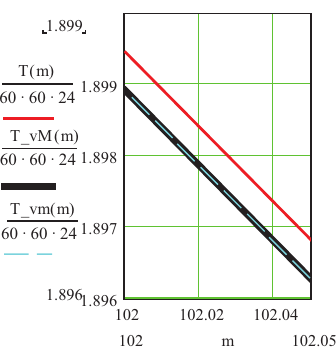
Figure 7. Optimal solution delivering the maximal value to the objective functional of the aircraft horizontal flight endurance The labeling of the respective axes in Figure 7 is as ( ) T m follows. The ordinate axis designation stands 60 60 24 ⋅ ⋅ for the values of endurance T obtained by Equation (9) with the use of the optimal speed (Eq. (10)) and data of ( ) T_vM m (Eq. (11)). means the endurance of T obtained 60 60 24 ⋅ ⋅ by the Equation of (Eq. (9)) with the use of the optimal ( ) T_vm m speed (Eq. (10)) variation ( ) v_M m whereas 60 60 24 ⋅ ⋅ is T by (Eq. (9)) with the use of the (Eq. (10)) variation v_m(m) (see Figure 6). The abscissa axis m value is the independent variable of mass m